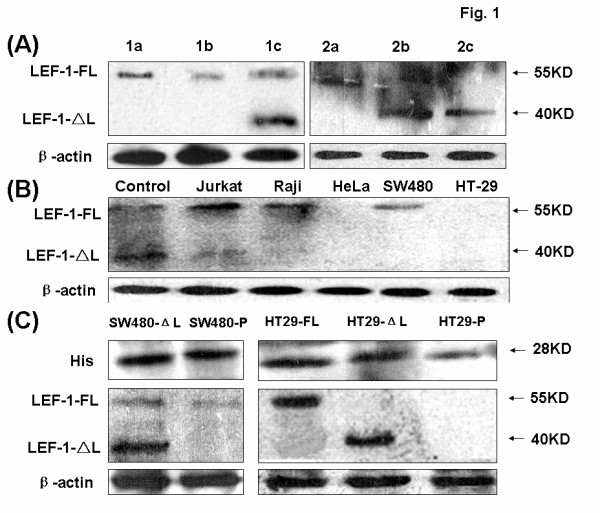
LEF-1 expression in colon cancer lines and primary tissue. (A) The expression of LEF-1 in primary tissue was examined by western blot. Every sample from the 22 patients was studied, and two representative samples are shown. 1a and 2a denote colon carcinomas; 1b and 2b denote adjacent tissues; 1c and 2c denote normal colon tissues. The molecular weight of full-length LEF-1 is about 55 KD and for LEF-1-ΔL it is 40 KD. (B) The expression of LEF-1 in different cell lines was examined by western blot. Control denotes Jurkat cell lysis (Invitrogen). (C) The expression of His tag (about 28 KD) and LEF-1 in SW480 and HT29 cells expressing LEF-1-ΔL or LEF-1-FL was examined by western blot. β-Actin was detected as a reference control. SW480-P is short for SW480-pCDNA3.1-His, and HT29-P is short for HT29- pCDNA3.1-His.